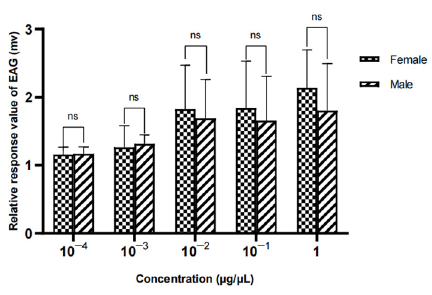
Figure 24. Comparison of EAG responses of W. magnifica to methylheptenone.